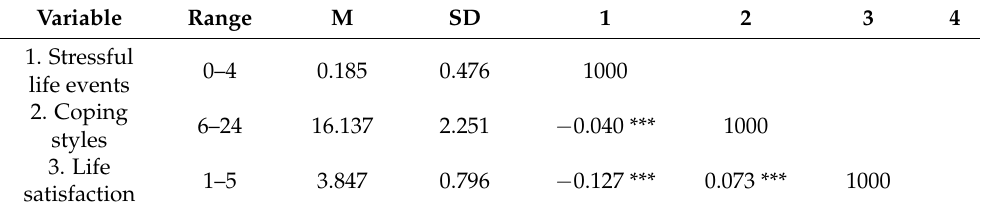
Table 2. Descriptive statistics and bivariate correlations of key variables ( n = 8799).